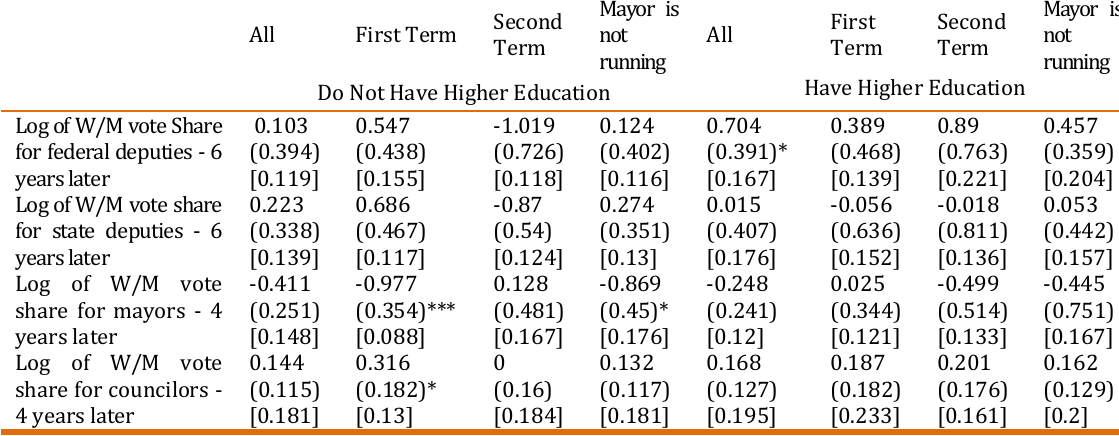
Table 05. Success of women in politics - stratified results by educational level